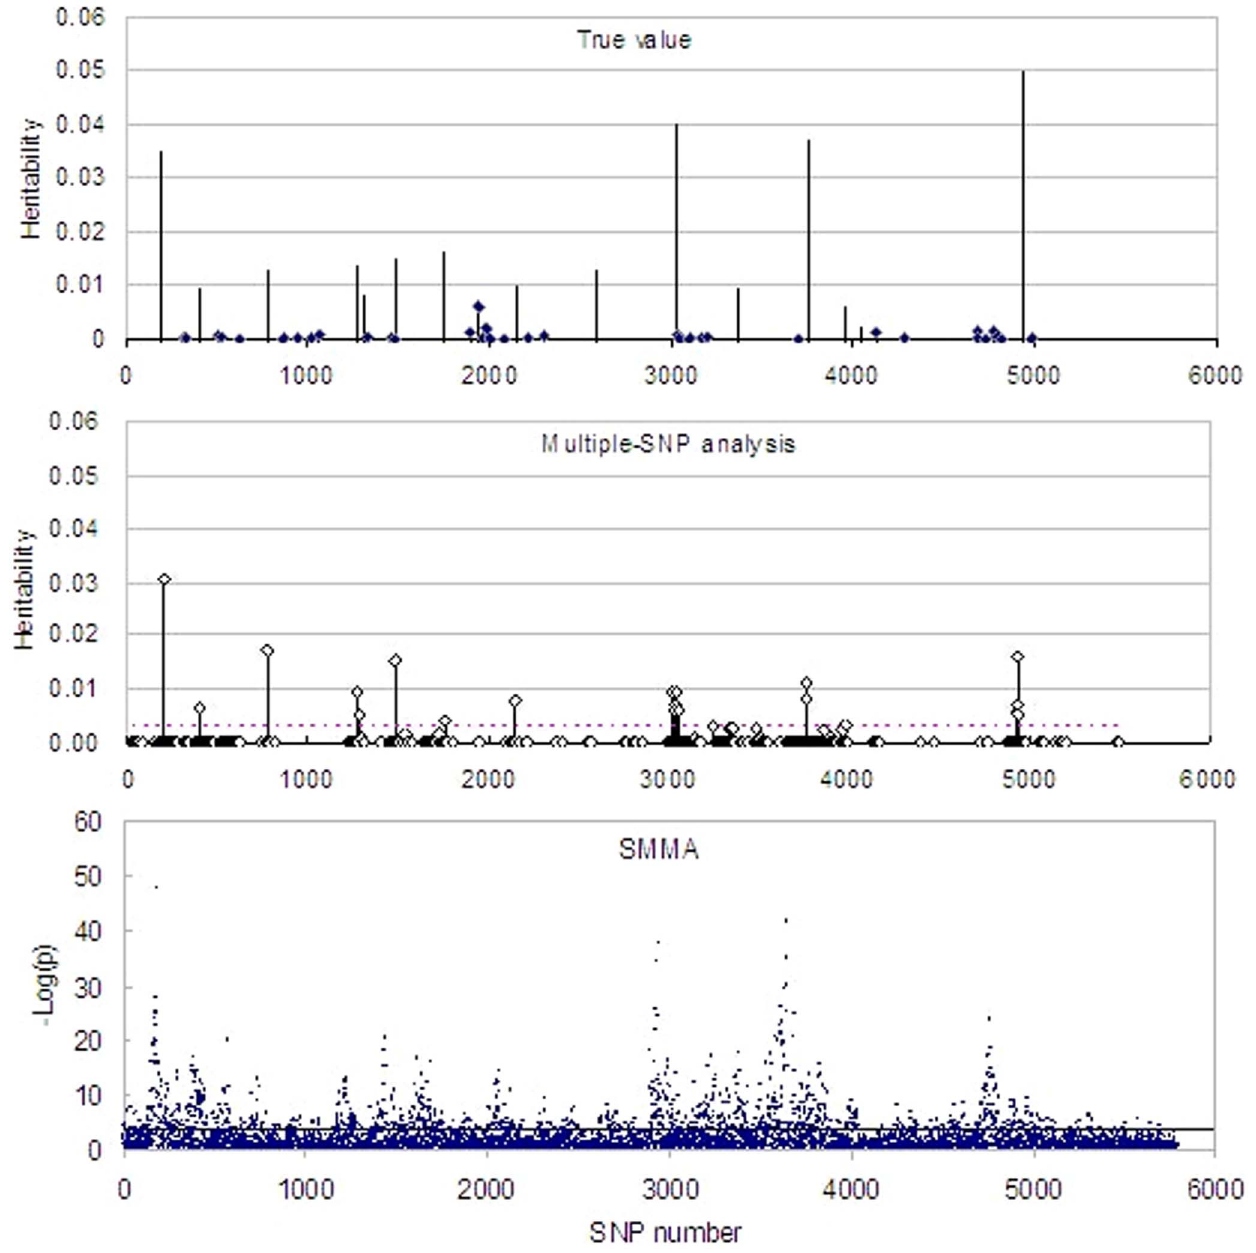
Figure 1. The profiles of the true SNP parameters (the top panel), the estimated 500 SNP heritabilities with MEML (the middle panel) and 2 log 10P with SMMA (the bottom panel), respectively. The x-axis indicates the SNP numbers. In the top panel, the true heritabilities of small-effect SNPs are presented with diamonds on the top of their needles but not for large-effect SNPs. The dotted horizontal lines in the middle and the bottom panels present the thresholds with 1,000 permutations from the multiple-SNP and SMMA methods,